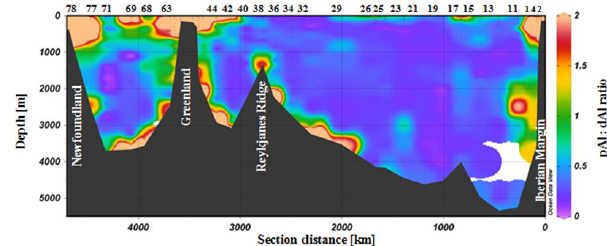
Figure 5. Cross-section plot of the pAl to dAl ratio (mol:mol) over the full depth of the water column. Plots created in Ocean Data View (Schlitzer,